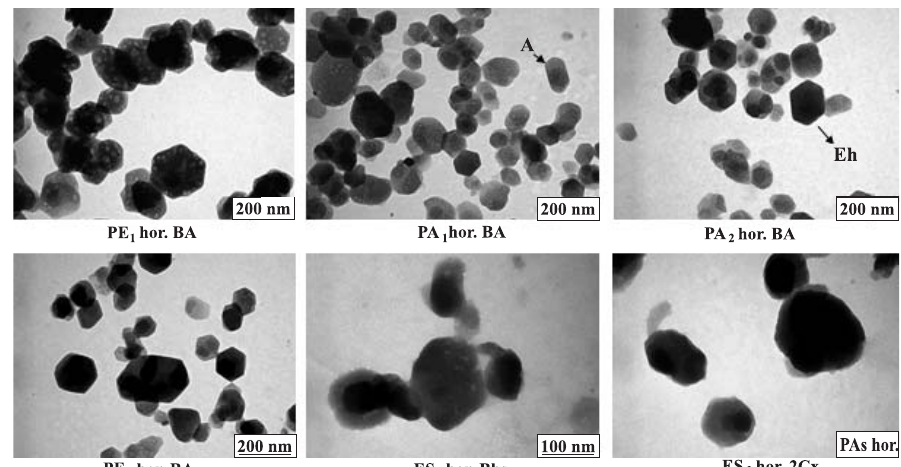
Figura 7. Micrografia de MET de amostras de caulinitas menores que 0,2 μ m desferrificadas dos solos estudados, ilustrando a ampla variação de morfologia - A: alongada; Eh: euedral hexagonal; sE: subesférica; Ef: esférica; I: indefinida. Escala em